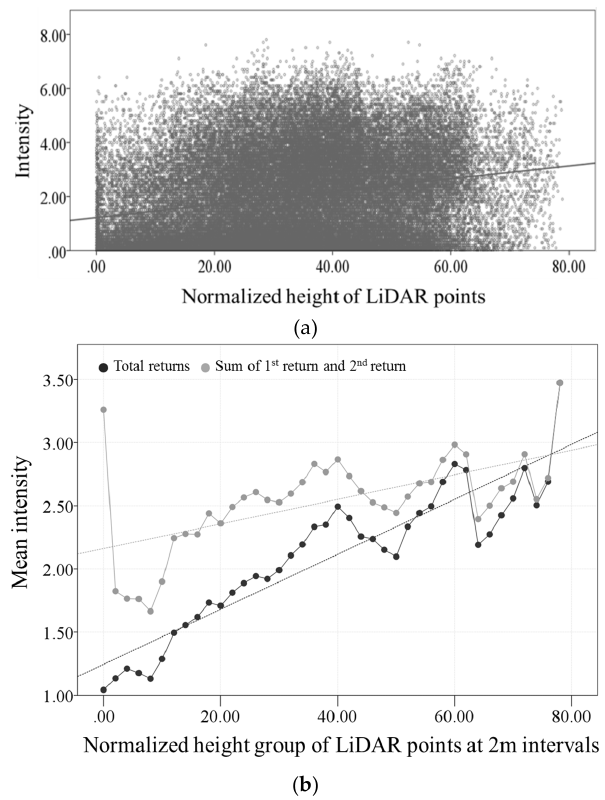
Figure 5. The relationship between ( a ) normalized height and intensity value and ( b ) normalized height group of LiDAR points at 2 ‐ m intervals and mean intensity. height group of LiDAR points at 2-m intervals and mean